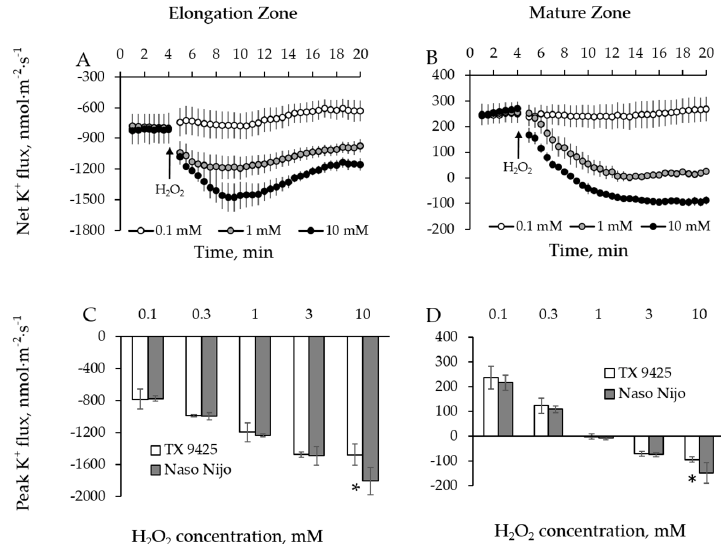
Figure 2. ( A , B ) Net K + fluxes measured from barley variety TX 9425 root elongation zone ( A )—about 1 mm from the root tip and mature zone ( B )—about 30mm from the root tip with respective H 2 O 2 concentrations. ( C , D ) Dose-dependency of H 2 O 2 -induced K + fluxes from root elongation zone ( C ) and mature zone ( D ). Error bars are means ± SE ( n = 6–8). Asterisks indicate statistically significant differences between two varieties (* p < 0.05, Student’s t -test). Responses from Naso Nijo were qualitatively similar to those shown for TX 9425.